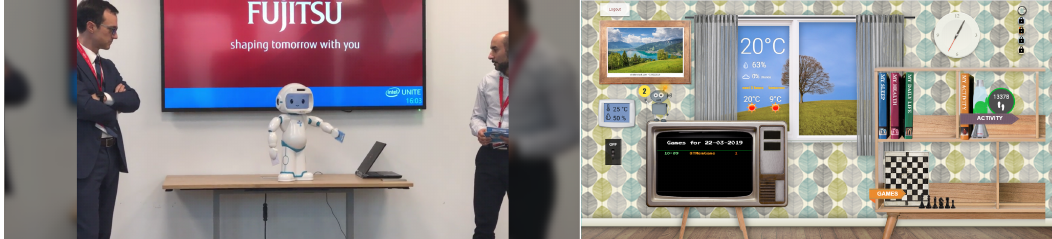
Figure 4. QTrobot playing games and results are uploaded and shown in the eWALL interface of CC2U